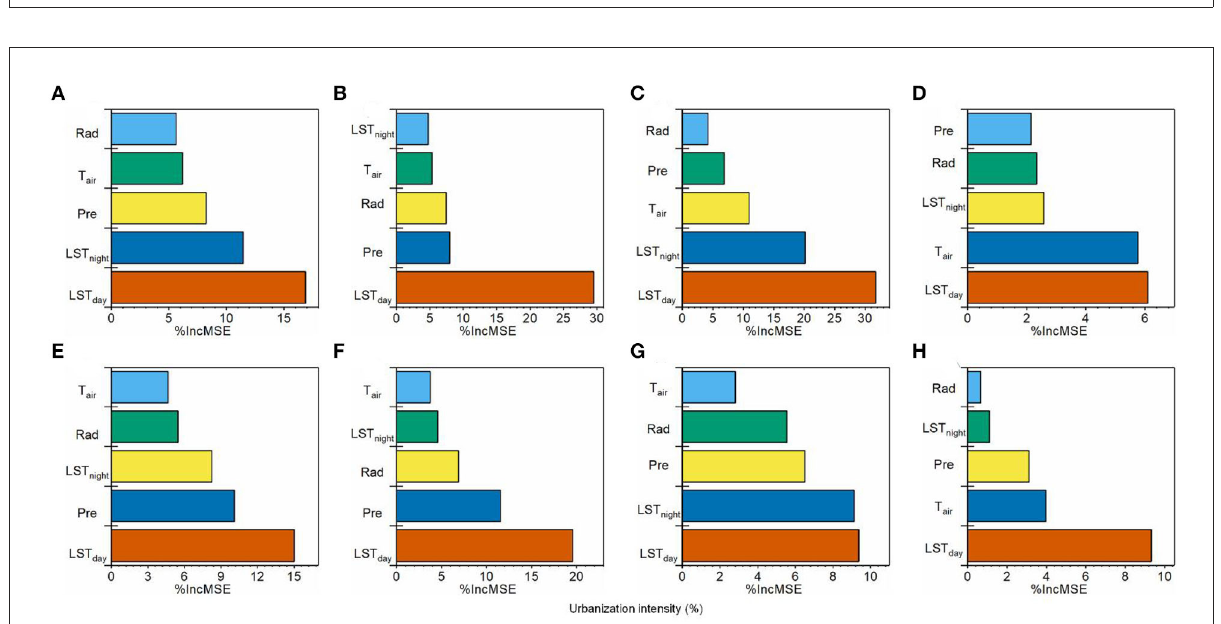
FIGURE7 The relative importance of climatic factors to growth offset of urbanization on GPP max and EVI max for the study area (A,E) , forest (B,F) , grassland (C,G) , and wetland (D,H) in 2020. LST day , land surface temperature of the day; LST night , land surface temperature of the night; Pre, annual precipitation; Tair, mean annual air temperature; Rad, solar radiation. The values were signed by the percentage increase of mean squared error (%IncMSE) in the RF model.